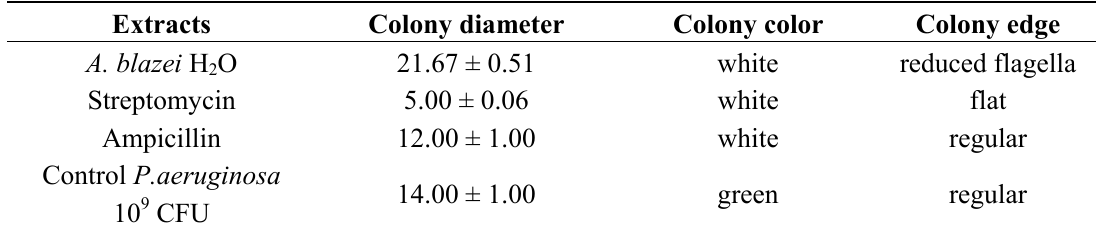
Table 3. Effect of Agaricus blazei extract on twitching activity, colony diameter and color of Pseudomonas aeruginosa (mean ±